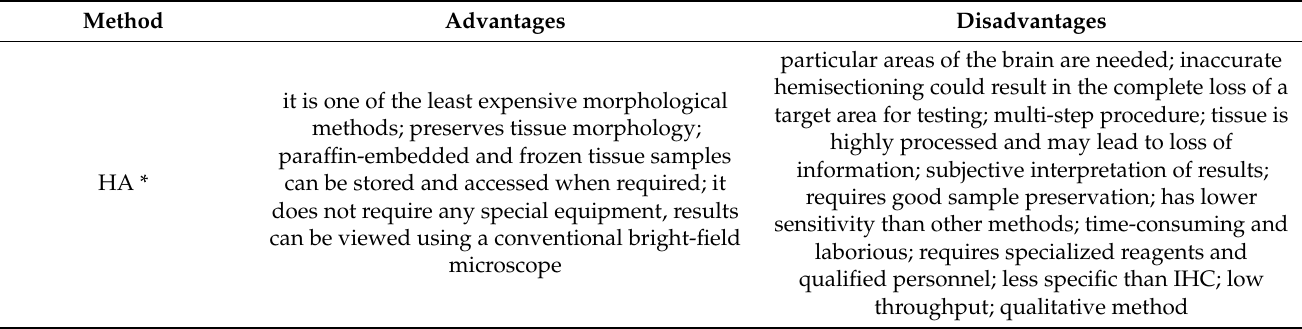
Table 3. The advantages and disadvantages of main methods for BSE diagnostic